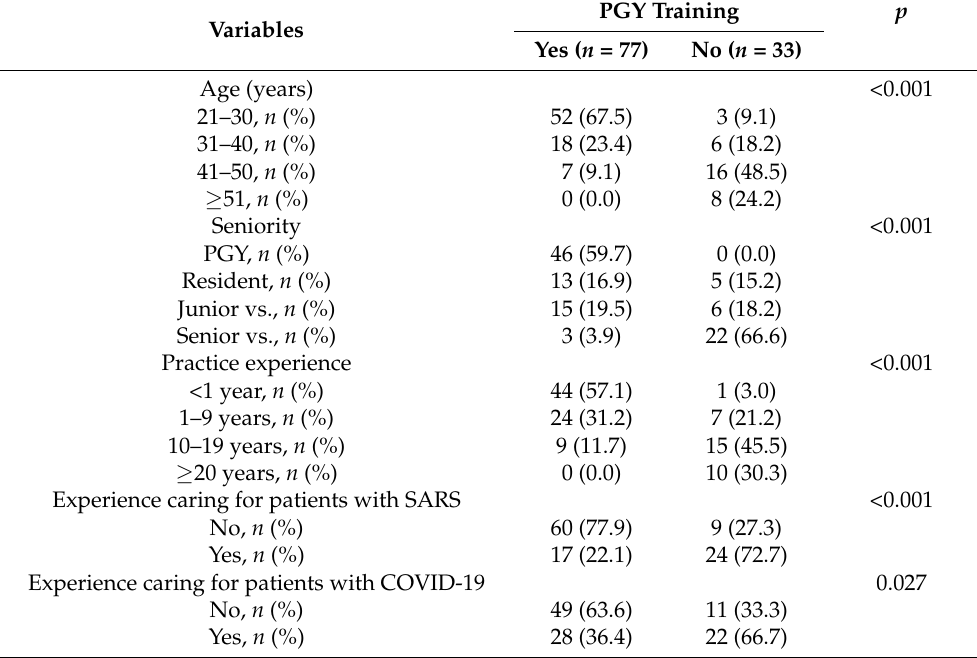
Table 1. Sociodemographic characteristics of the study